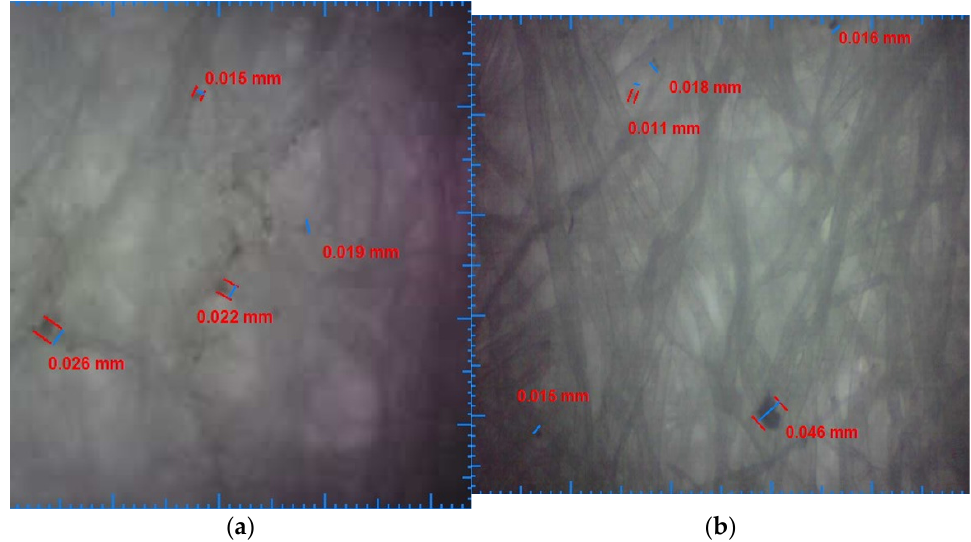
Figure 6. ( a ) Fabric filter water deposits sample; ( b ) washable filter water deposits sample.